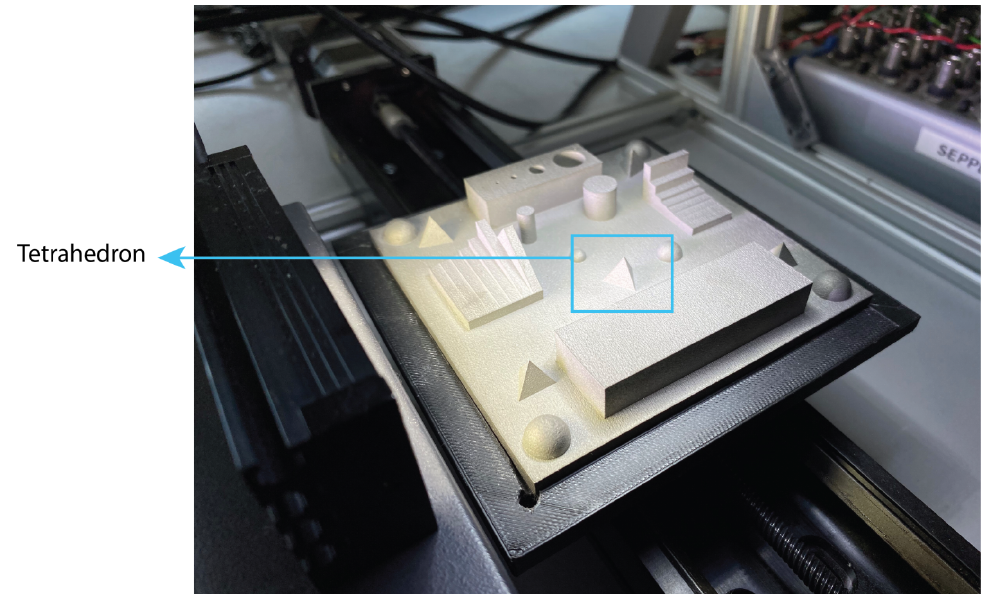
Figure 7. The calibration target and the tetrahedron feature to be measured using both